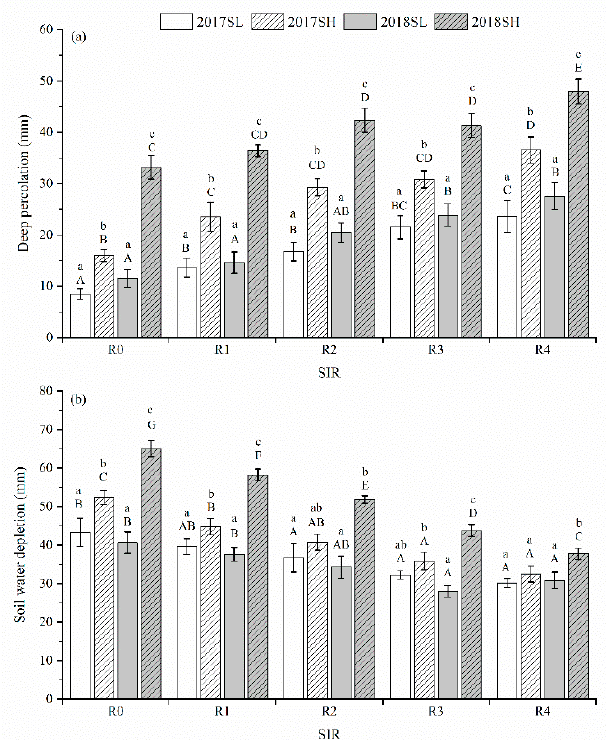
Figure 2. Soil water depletion ( a ) and deep percolation ( b ) response to straw incorporation rates (SIRs) and irrigation water salinity (IWS) in 2017 and 2018. Note: SL indicates the low salinity water (1.92 dS m − 1 ); SH indicates the high salinity water (3.20 dS m − 1 ). Lowercase letters indicate significant differences between different YEAR and IWS combinations for the same SIR treatment and uppercase letters indicate significant differences between different IWS and SIR combinations for the same YEAR. Data without the same letter differ significantly at the p = 0.05 level.